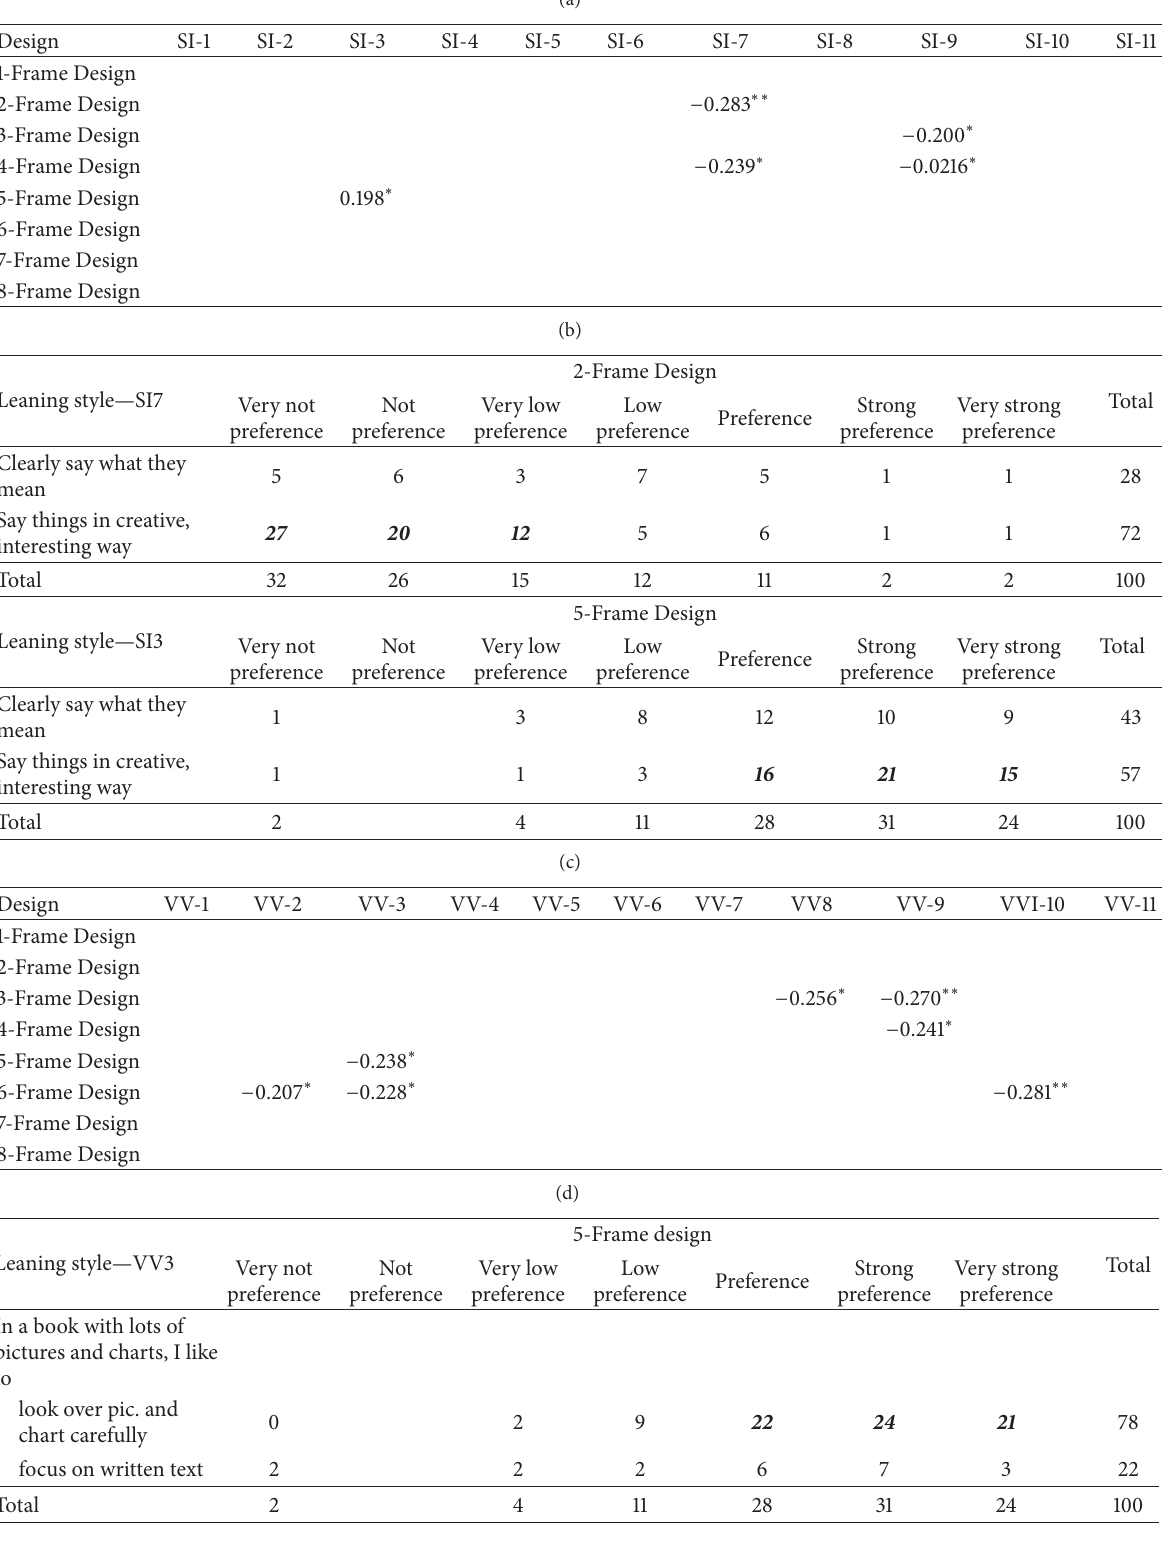
Table 25: (a, b) Correlation between learning style of “Sensing-Intuitive” type versus the preferences of the 8 designs proposed. (c, d) Correlation between learning style of “Visual-Verbal” type versus the preferences of the 8 designs